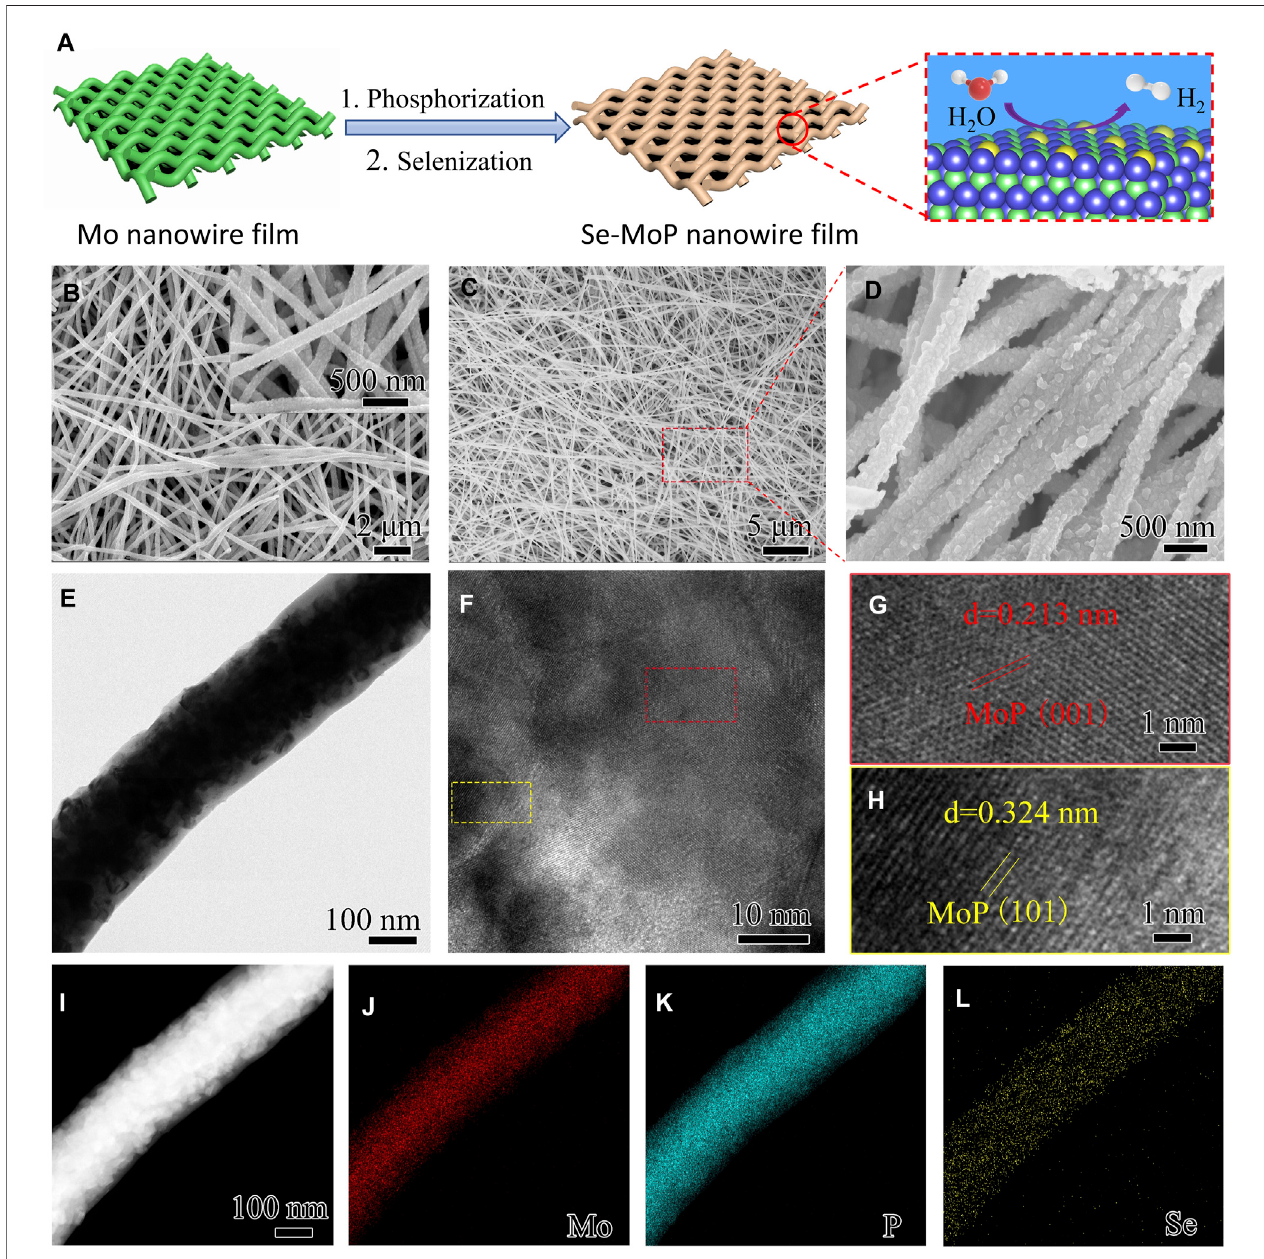
FIGURE1|(A) SyntheticrouteoftheSe-MoPnanowire fi lm.Theblue,green,yellow,red,andwhitespheresrepresentMo,P,Se,O,andHatoms,respectively. (B) SEM images of MoP nanowires and (C – D) Se-MoP nanowires. (E) TEM, (F – H) HRTEM, (I) HAADF-STEM images of the Se-MoP nanowires and the corresponding elemental mapping images of (J) Mo, (K) P, and (L) Se elements. The inset in Panel (B) represents corresponding high-magni fi cation SEM image of MoP nanowires.